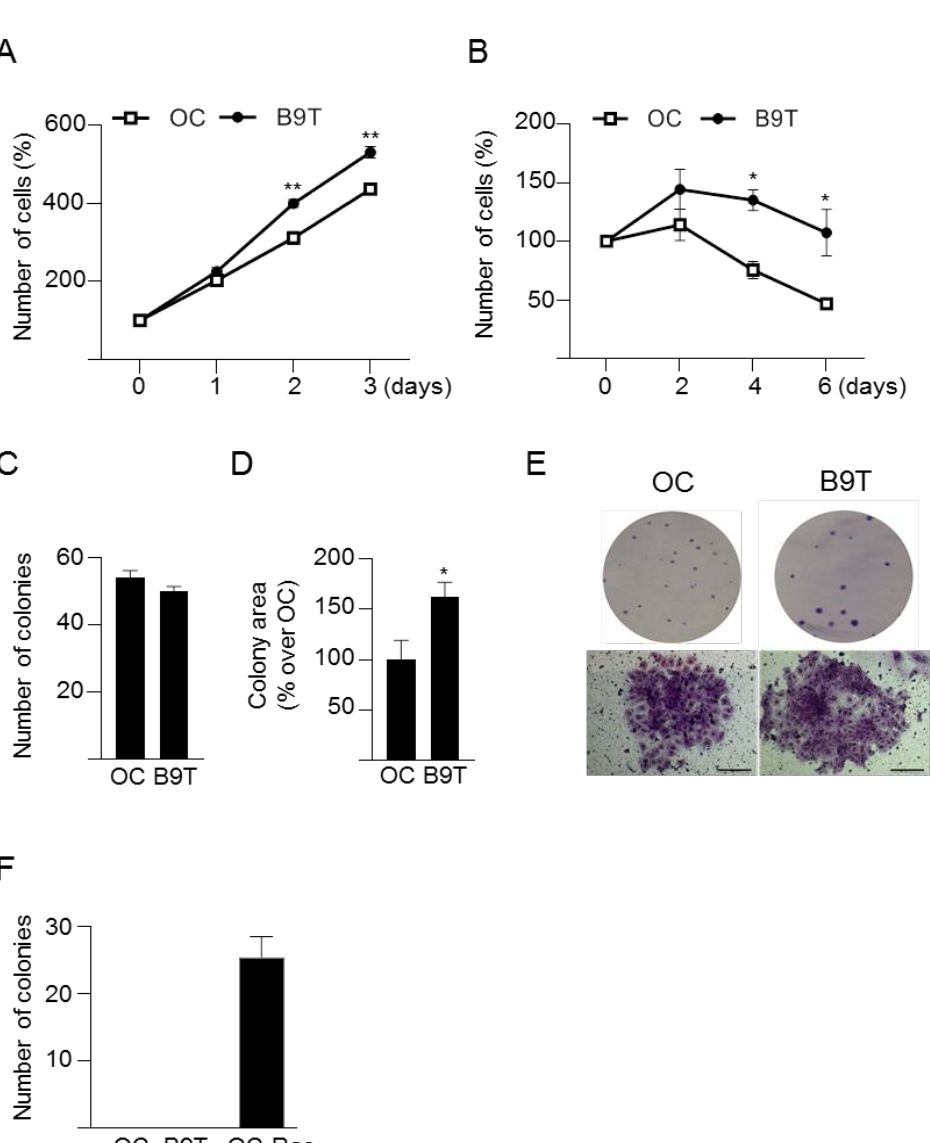
Figure 3. Analysis of B9T-OC growth capacity . ( A , B ). Oval cells (OC) and B9T-OC (B9T) were cultured in the presence ( A ) or absence ( B ) of 10% FBS for different periods of time and the number of cells was counted. Data are expressed with respect to day 0 (assigned as 100%) (mean ± SEM) and are from three to four independent experiments performed in triplicate. ( C – E ). Oval cells (OC) and B9T-OCs (B9T) were seeded at low density and maintained in 10% FBS-supplemented medium for up to 10 days. ( C ) Total number of colonies (mean ± SEM) ( n = 6) and ( D ) the colonies area ( n = 6) were determined. Colony area data are expressed relative to OC. ( E ) Representative images of clones from a plate (upper images) and representative phase contrast microscope images of individual foci (lower images, scale bar = 100 µm). ( F ) Soft agar assay with oval cells (OC), B9T-OC (B9T) and oval cells expressing v-Ha-Ras (OC-Ras). Colonies were counted after 3 weeks in culture ( n = 4). * p < 0.05, ** p < 0.01, B9T-OC vs. OC.